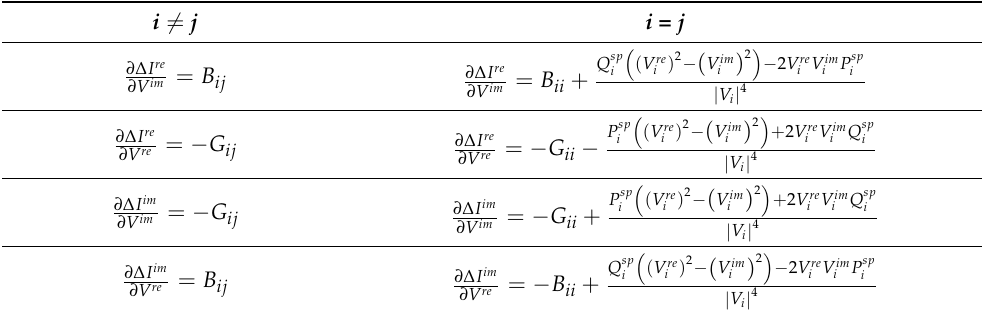
Table 1. PartialderivativesinthecurrentmismatchloadflowformulationconsideringCartesian